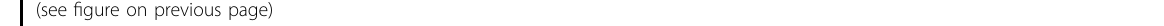
Fig. 4 Structural connectivity and YBOCS reduction. A White matter fi bres connected to the stimulation fi eld and discriminative of outcome were isolated in the right hemisphere. These included a fi bre tract passing through the midbrain to the ventrolateral prefrontal cortex and a fi bre tract connecting the site of stimulation with the amygdala. Fibres in this region also passed through the hippocampal white matter and returned to the BNST via the stria terminalis adjacent to the fornix. Subcortical parcellations of the amygdala, hippocampus and fornix were derived from recent automated segmentation methods 77 – 79 . Additional views presented in Supplementary Fig. 4. B An optimal connectivity pro fi le was generated by identifying those brain voxels structurally connected with the stimulation fi eld and most highly correlated with YBOCS reduction. Cortical regions implicated in this optimal right-hemispheric ‘ R-map ’ included ventromedial and ventrolateral prefrontal cortex, dorsomedial prefrontal cortex, medial temporal cortex, parietal cortex and extrastriate visual cortex. These fi ndings were corroborated in a leave-one-out cross-validation, in which each participant ’ s percentage YBOCS reduction was predicted by comparing their structural connectivity pro fi le with an optimal connectivity map derived from the remaining participants. C In a region of interest analysis, cortical regions derived from the R-map were tested in a multivariate linear mixed- effects model for their association with YBOCS